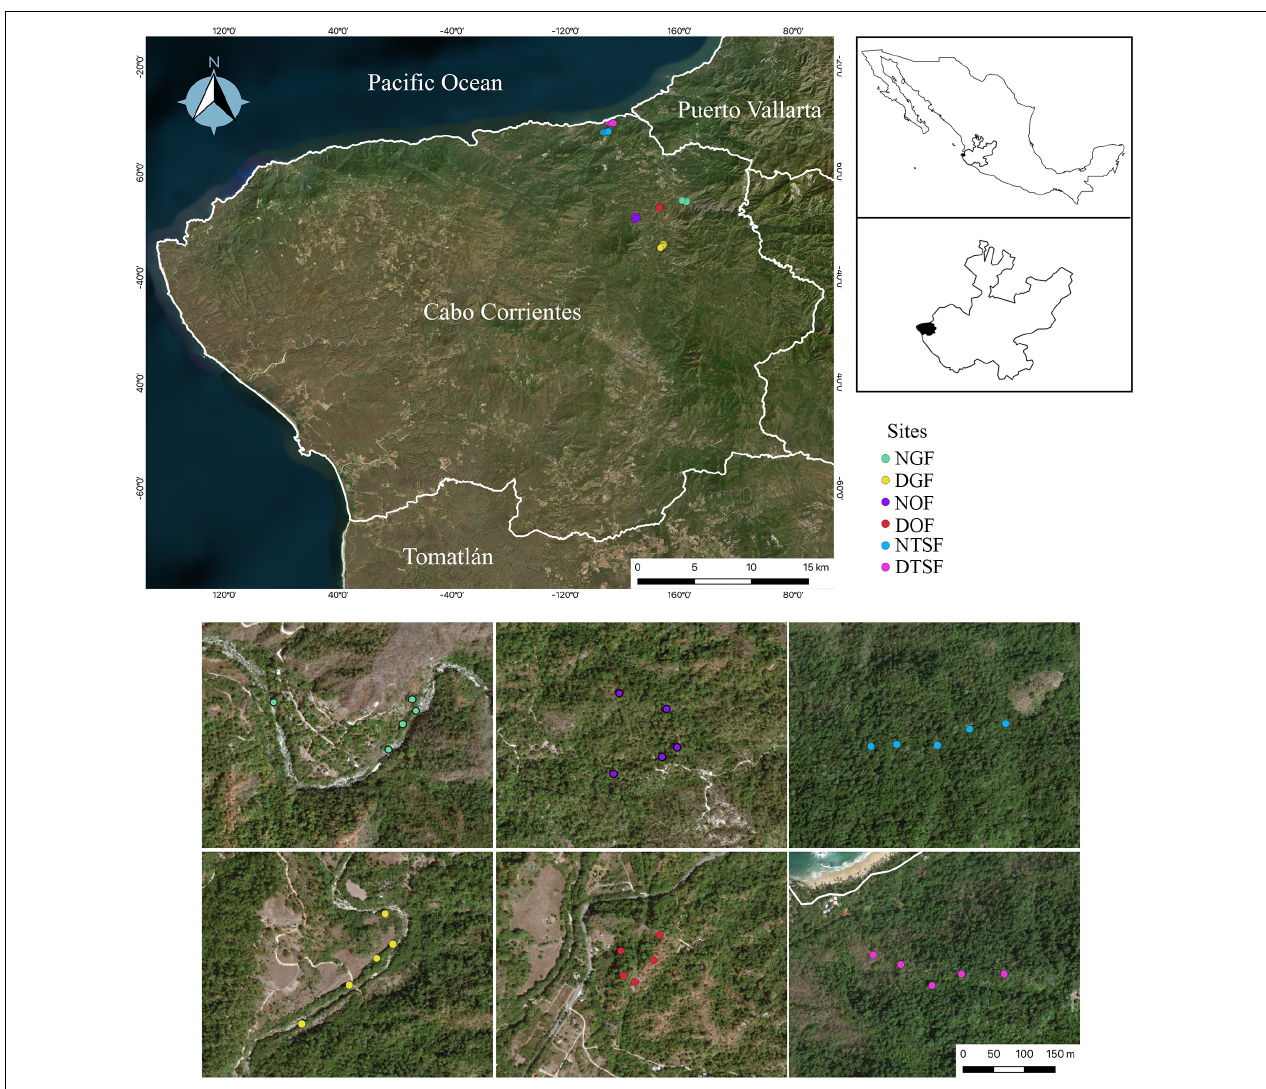
FIGURE 1 | Study area and location of the six sampling sites (NGF = natural gallery forest, DGF = disturbed gallery forest, NOF = natural oak forest, DOF = disturbed oak forest, NTSF = natural tropical sub-deciduous forest, DTSF = disturbed tropical sub-deciduous forest) in Cabo Corrientes, Jalisco, Mexico. (Google Earth Pro,